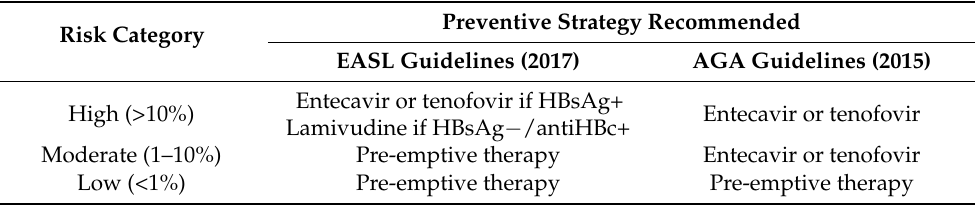
Table 4. HBV reactivation prophylactic strategies according to risk category. Preventive Strategy Risk Category